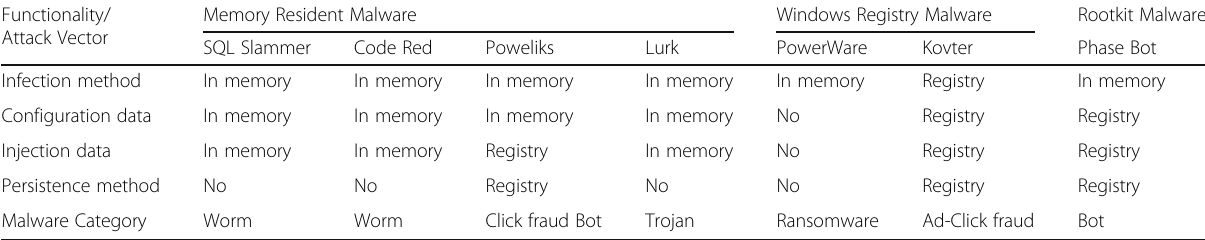
Table 3 Classification of Attack Vectors for Fileless Malware detection Functionality/ Attack